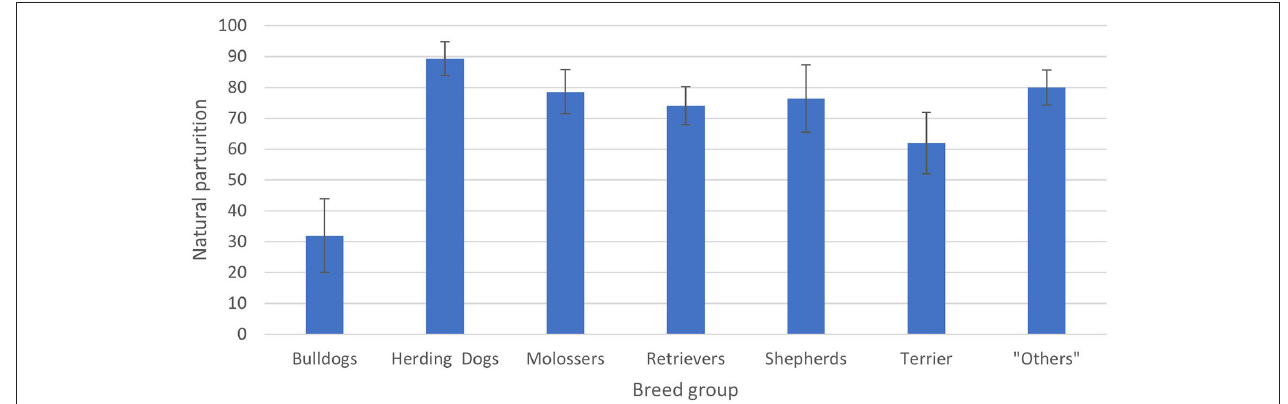
FIGURE 2 | Estimated frequencies [LSMeans ± standard error (SE)] for natural parturition depending on breed groups in case of pregnancy after a previous parturition. Significant differences could be obtained for the comparisons between breed group 1 (bulldogs) (31.95 ± 12.00%) and 2 (herding dogs) (89.30 ± 5.44%; p = 0.0079) and between breed group 1 (bulldogs) and 6 (others) (80.07 ± 5.66%; p = 0.0285). All other comparisons showed no significant differences ( p >